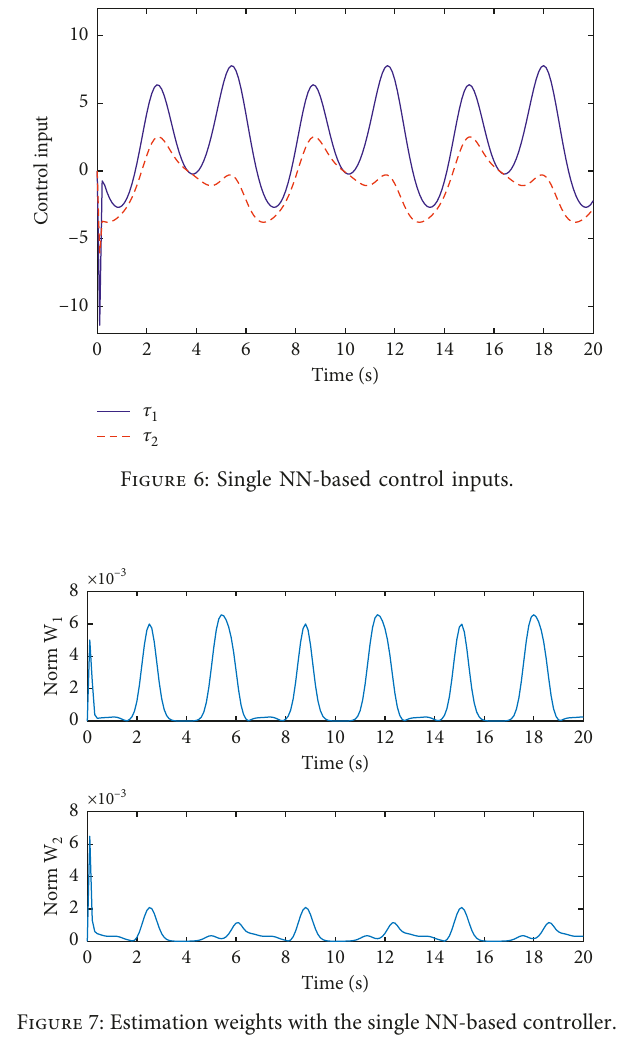
and q of the single NN- 1 2